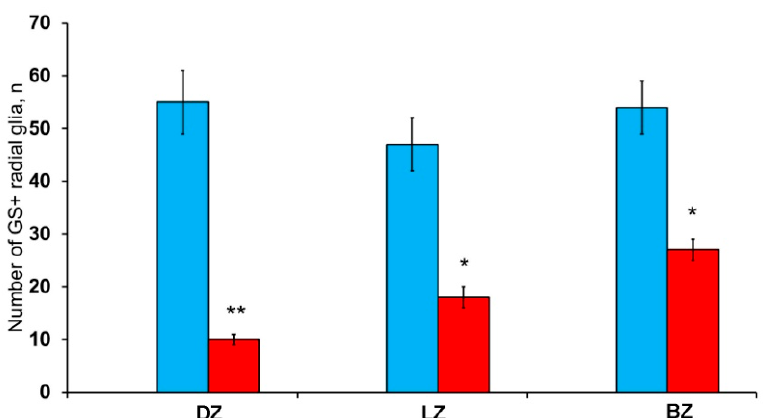
Figure 15. The number of GS+ radial glia (RG) in the intact and injured cerebellum of juvenile masu salmon, Oncorhynchus masou . ( n = 5 in each group; * p ≤ 0.05 and ** p ≤ 0.01 is a significant difference vs. control groups). Student–Newman–Keuls test. The cerebellum areas of juvenile O. masou are plotted on the X-axis. Blue bars are for intact cerebellum, and red bars are for damaged cerebellum. DZ, dorsal zone; LZ, lateral zone; BZ, basal zone.